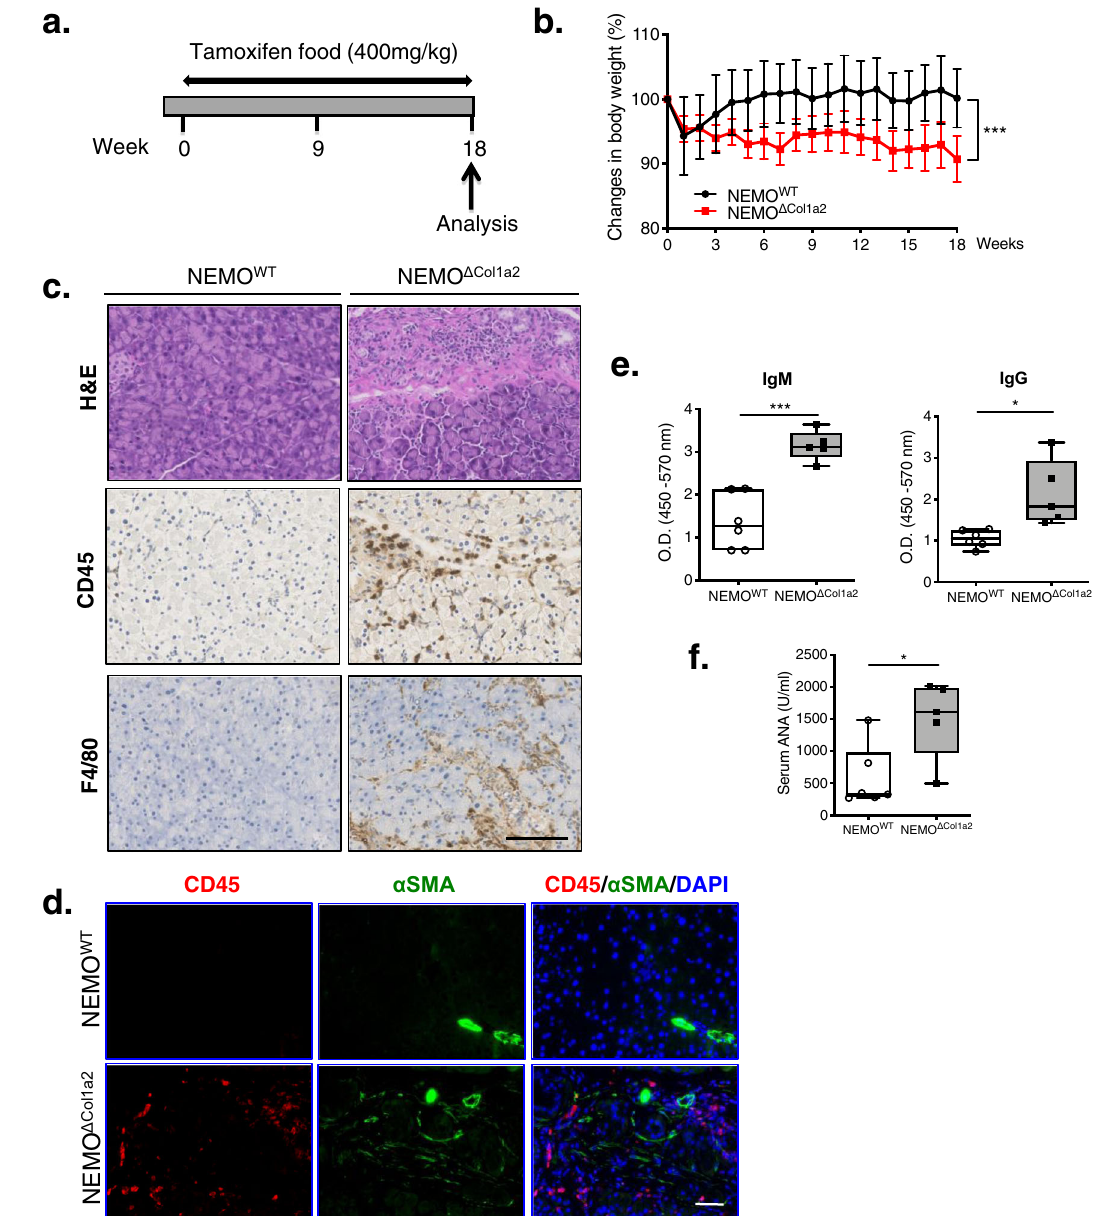
Fig. 1 Spontaneous pancreatitis develops in NEMO Δ Col1a2 mice after long-term NEMO inhibition. a Scheme of treatment with tamoxifen diet (400 mg/ kg) for 18 weeks. b Body weight changes during the 18 weeks of treatment period. Mean±SD (NEMO WT : n = 9; NEMO Δ Col1a2 : n = 8). Area under the curve was compared. c Spontaneous pancreatitis and in fi ltration of immune cells observed in NEMO Δ Col1a2 pancreata. Scale bar: 100 µ m. d Staining of CD45 and α SMA indicated an increase in activated pancreatic stellate cells at area where abundant immune cells were present. Scale bar: 50 µ m. e , f Circulating IgM, IgG and ANA levels measured by ELISA on serum samples (NEMO WT : n = 6; NEMO Δ Col1a2 : n = 5). Whiskers: Min to Max. T -test (two-tailed): * p < 0.05; *** p < 0.001. All n numbers represent biological